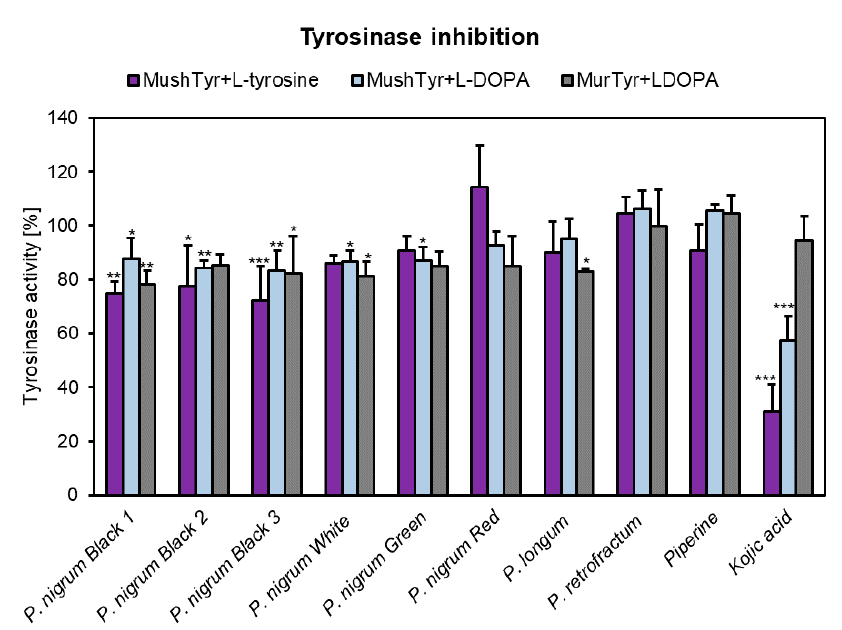
Figure 5. Tyrosinase inhibitory activity of the methanolic fruit extracts (10 µ g/mL) obtained from different spices of genus Piper , piperine (10 µ g/mL) and kojic acid (10 µ g/mL). Data are presented as percentage of tyrosinase activity in comparison to solvent (DMSO) control, set at 100%. Each bar represents the mean ± S.D. of three determinations; * p < 0.05; ** p < 0.01; *** p < 0.001 vs. control.